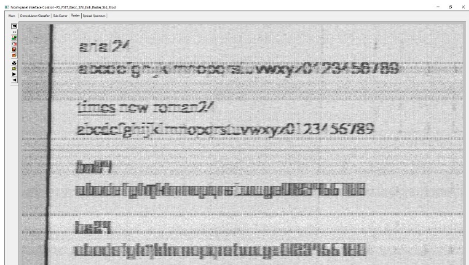
Figure 15. Image recovered with Font 24: Arial, Times New Roman, secure asymmetrical and secure symmetrical.